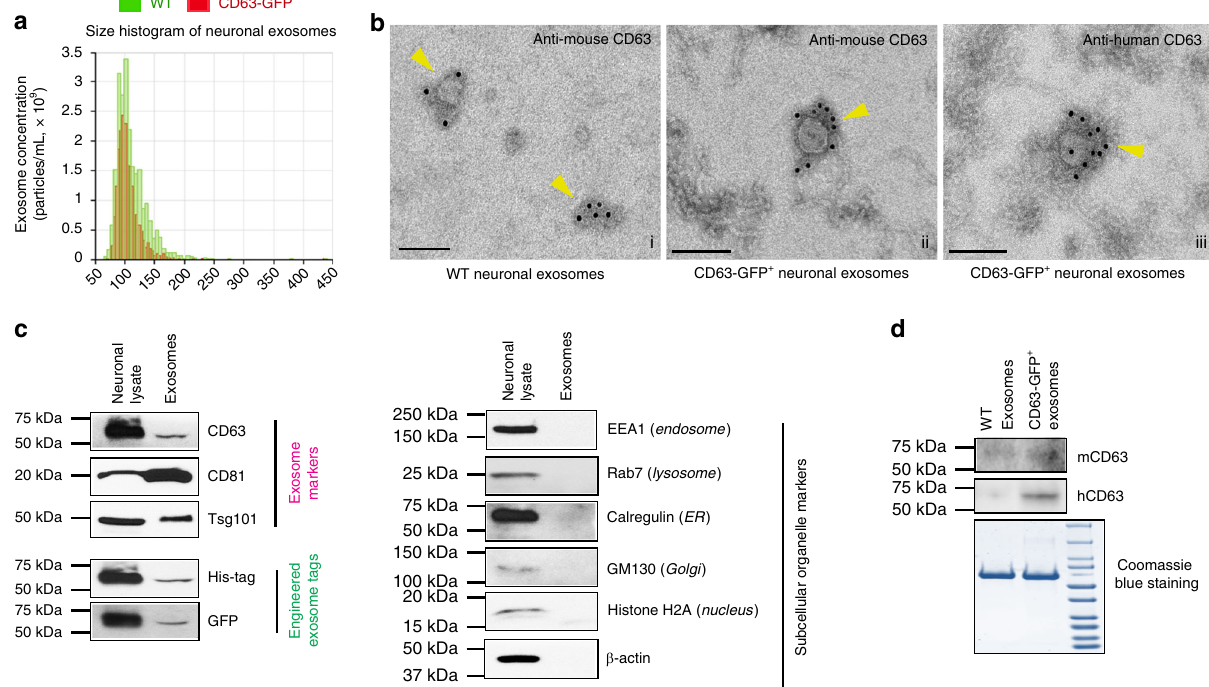
Fig. 2 Secretion of CD63-GFP + exosomes from CD63-GFP f/ + primary neurons. a Representative size distribution of exosomes isolated from conditioned medium of cultured WT (green) and AAV-CaMKII-Cre transduced CD63-GFP f/ + (red) primary neurons by the qNano particle analyzer. b Representative immuno-Electron Microscopy (EM) images of human and mouse CD63 labeling on in vitro prepared WT and CD63-GFP + neuronal exosomes. Scale bar: 100 nm; Subpanels i: anti-mouse CD63 on WT neuronal exosomes; ii: anti-mouse CD63 on CD63-GFP + neuronal exosomes; iii: anti-human CD63 on CD63-GFP + neuronal exosomes. Images were from a total of 40 – 50 images of two separate preparations. c Representative immunoblots of typical protein markers for exosomes, engineered exosome tags, and other subcellular organelles from lysate and puri fi ed exosome fractions of AAV-CaMKII-Cre transduced CD63-GFP f/ + neurons. d Representative immunoblot of induced human CD63 and endogenous mouse CD63 from WT and CD63-GFP